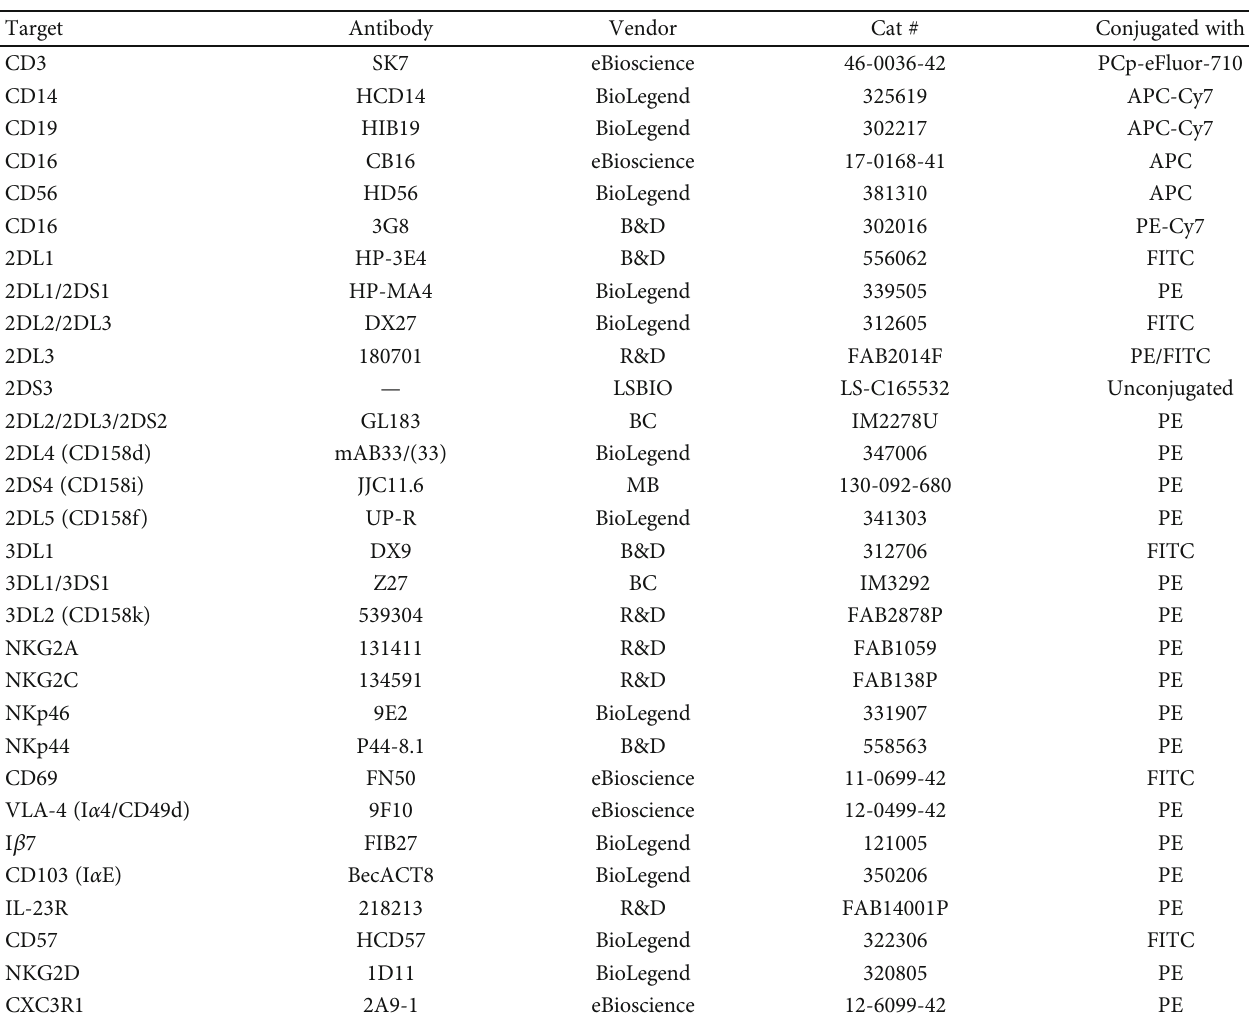
Table 2: List of antibodies used in this